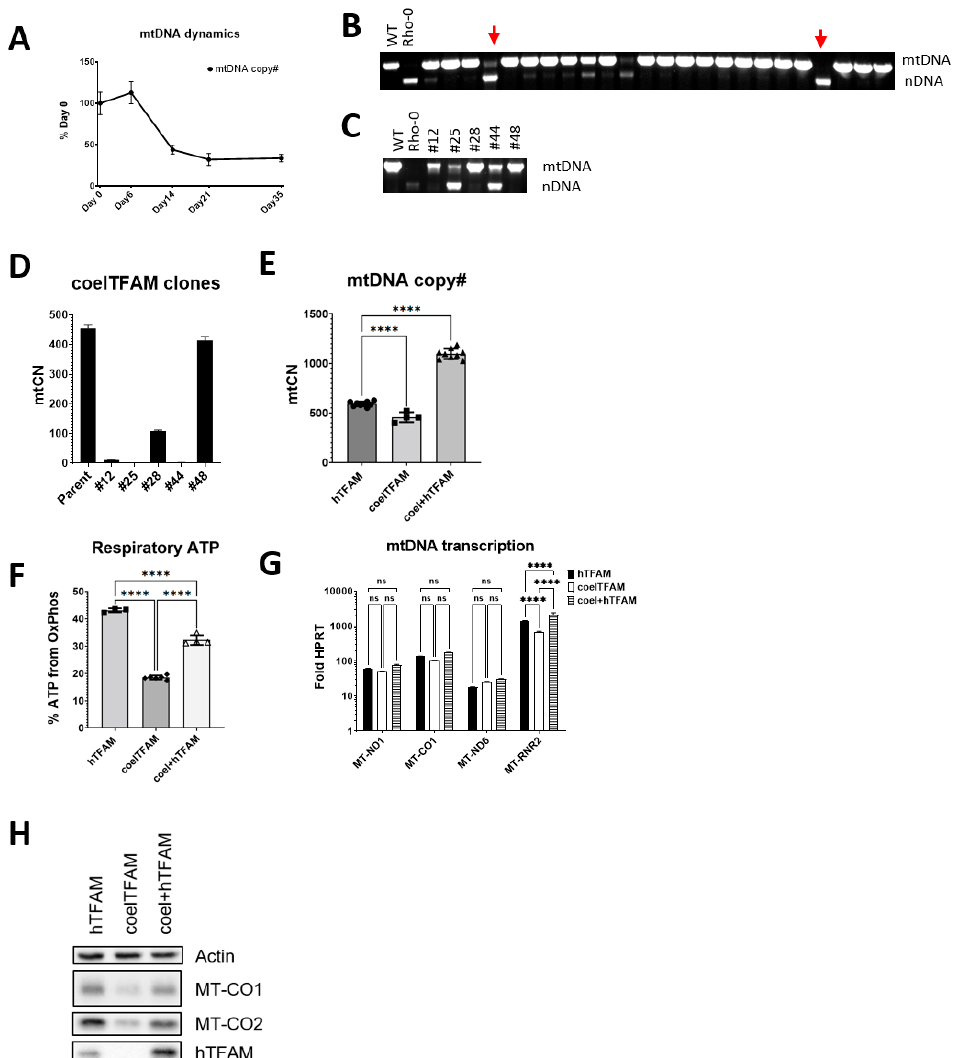
Figure 3. Coelacanth TFAM promotes spontaneous loss of hmtDNA. ( A ), Upon cultivation in +UP media, mtCN in cells expressing coelTFAM is reduced. Cells expressing coelTFAM were incubated in +UP media for up to 35 days, cell aliquots were collected at indicated intervals, and mtCN was determined by qPCR. ( B ), coelTFAM promotes spontaneous loss of mtDNA. Cells were grown in +UP media for 5 weeks, plated by limiting dilution, the resulting colonies were picked and tested for the presence of mtDNA. Red vertical arrows indicate clones that lost mtDNA. ( C , D ), in the experiment described in ( B ), clones representative of various mtCNs were analyzed by conventional ( C ) and dddPCR. ( D ). ( E ), Transduction with hTFAM augments mtCN in cells expressing coelTFAM. Cells expressing coelTFAM were selected in –UP media and transduced with a retrovirus rv.5132 (Supplementary Figure S2), which expresses hTFAM . ****, p < 0.0001. ( E ), One- way ANOVA with post hoc Tukey test. A representative of two independent experiments. ( F – H ), Changes in OXPHOS and mtDNA-encoded OXPHOS subunits expression correlate with expression of the MT- RNR2. ( F ), OXPHOS deficiency in cells expressing coelTFAM can be partially rescued with hTFAM. ****, p < 0.0001. One-way ANOVA with post hoc Tukey test. A representative of two independent experiments. ( G ), coelTFAM does not significantly affect expression of the MT-ND1, MT-CO1 , or MT-ND6 , but affects expression of the MT-RNR2 . Two-way ANOVA with Dunnet correction. ****, p < 0.0001; ns, not significant. ( H ), OXPHOS correlates with expression of mtDNA-encoded subunits MT-CO1 and MT-CO2. A representative of two independent